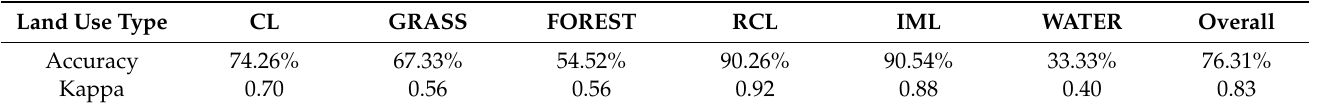
Table 5. Accuracy test of simulation results: cultivated land (CL), grassland (GRASS), forestland (FOREST), Rural construction land (RCL), industrial and mining area (IML), water (WATER).